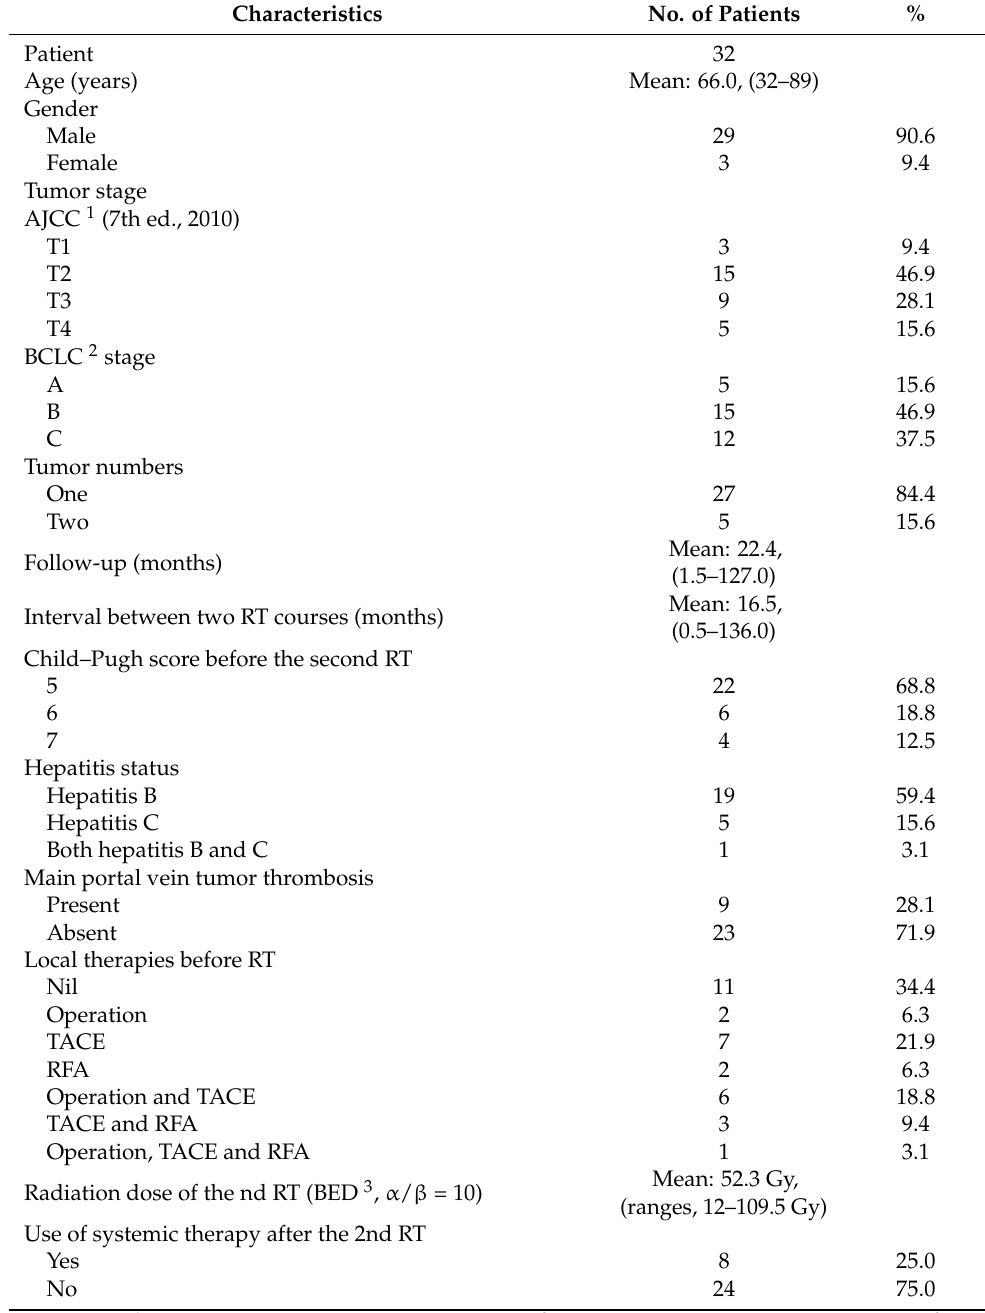
Table 1. Patient